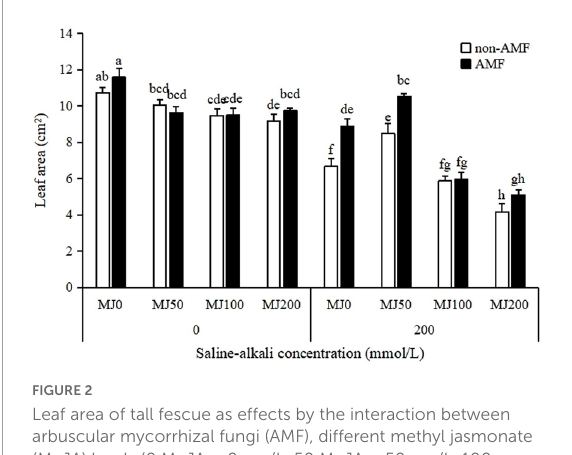
FIGURE2 Leaf area of tall fescue as effects by the interaction between arbuscular mycorrhizal fungi (AMF), different methyl jasmonate (MeJA) levels (0 MeJA = 0 mg/L, 50 MeJA = 50 mg/L, 100 MeJA = 100 mg/L, 200 MeJA = 200 mg/L) and saline-alkali stress. Different letters above the bars indicate significant differences according to Duncan’s multiple range test ( P ≤ 0.05).